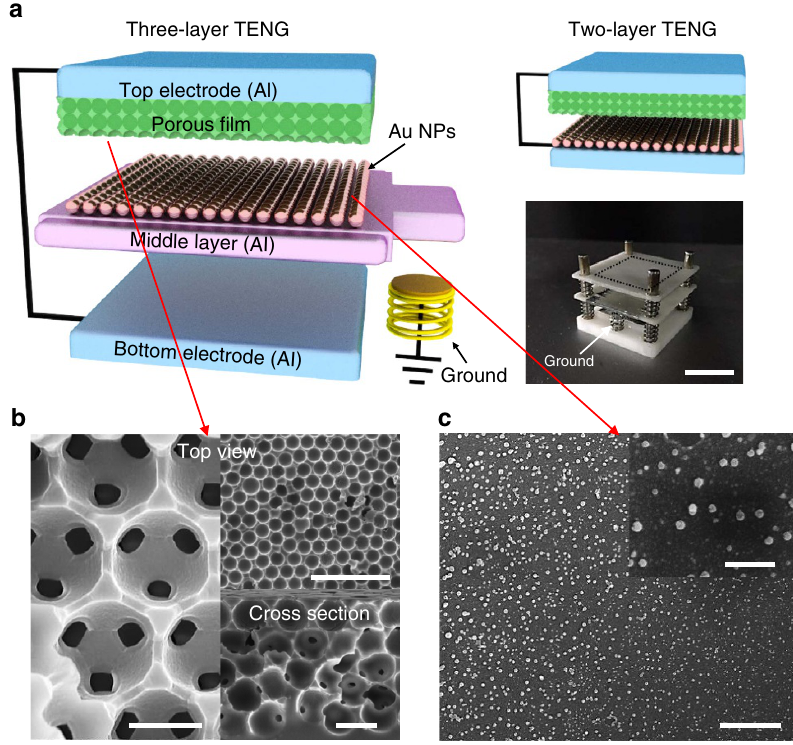
Figure 1 | Fabrication of three-layer structured triboelectric nanogenerator. ( a ) Schematic diagrams of the three-layer structured and two-layer structured triboelectric nanogenerator (TENG). The photograph of the nanogenerator is also shown. Scale bar, 1cm. ( b ) Scanning electron microscope (SEM) images of the mesoporous polymer film on the top electrode. Top-view SEM images in left side and top-right corner, and cross-sectional view SEM image in bottom-right corner with scale bars of 1, 50 and 10 m m, respectively. ( c ) Top-view SEM images of the middle layer with Al film coated by Au nanoparticles (Au NPs). Scale bar of 5 m m. The inset also shows the expanded view, with scale bar of 1 m